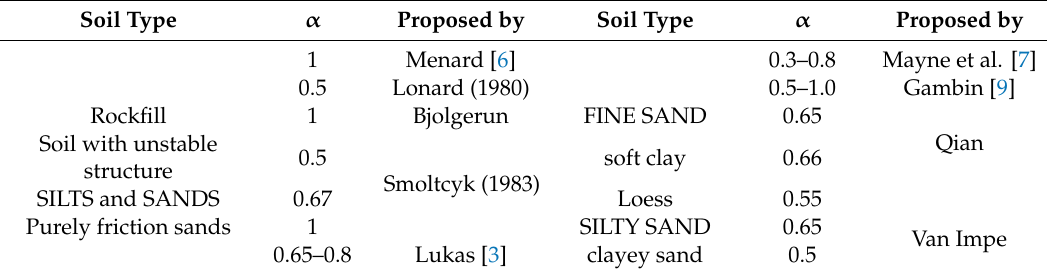
Table 3. Summary of empirical coe ffi cient of improvement depth, α